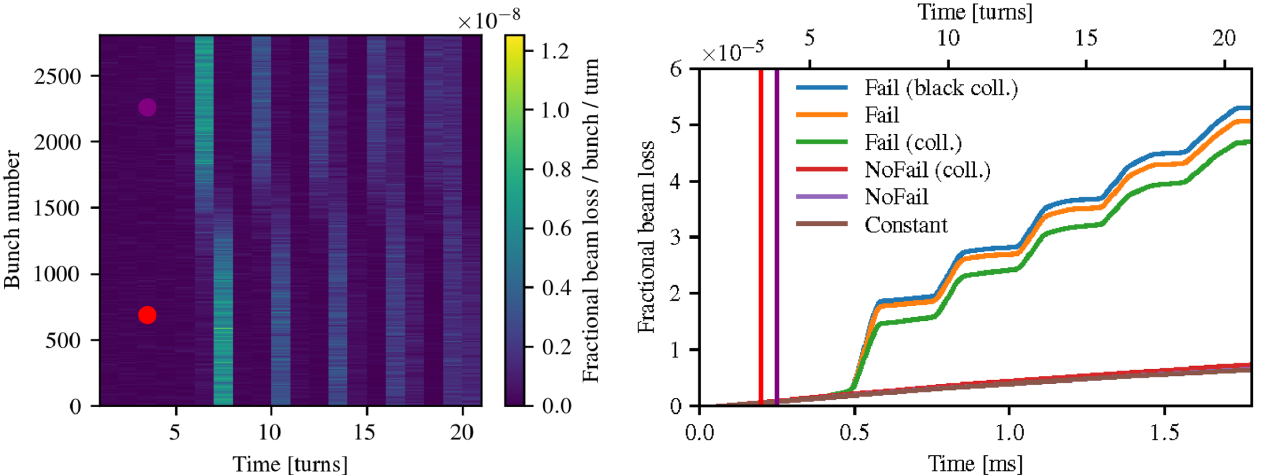
FIG. 15. Losses in the HL-LHC as a function of time; both instantaneous losses (left) for the Fail scenario, and cumulative losses comparing different scenarios and simulation techniques (right). The first vertical circle or line (red) marks the beginning of the quench, and the second circle or line (purple) the time when pressure detuning becomes important for the Fail